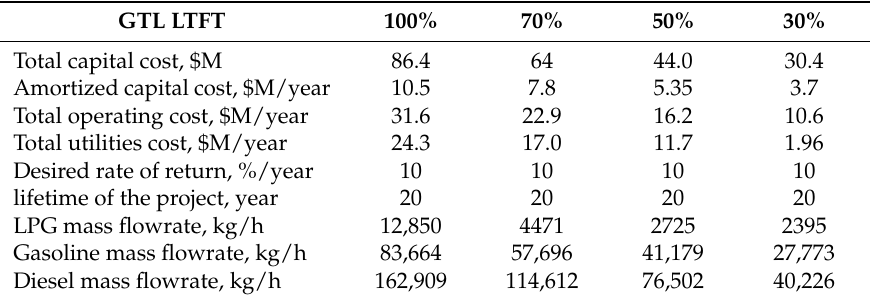
Table 6. GTL (LTFT) production results for different methane feedstock utilization levels. GTL